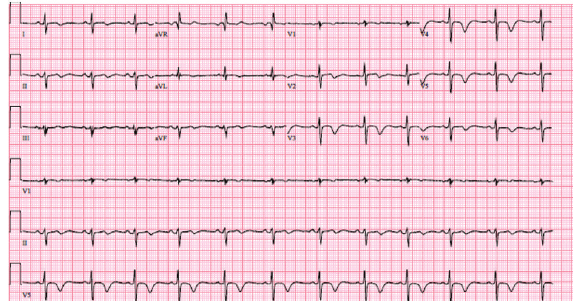
Figure 1: Electrocardiogram on the day of admission showing Wellens’ waves.